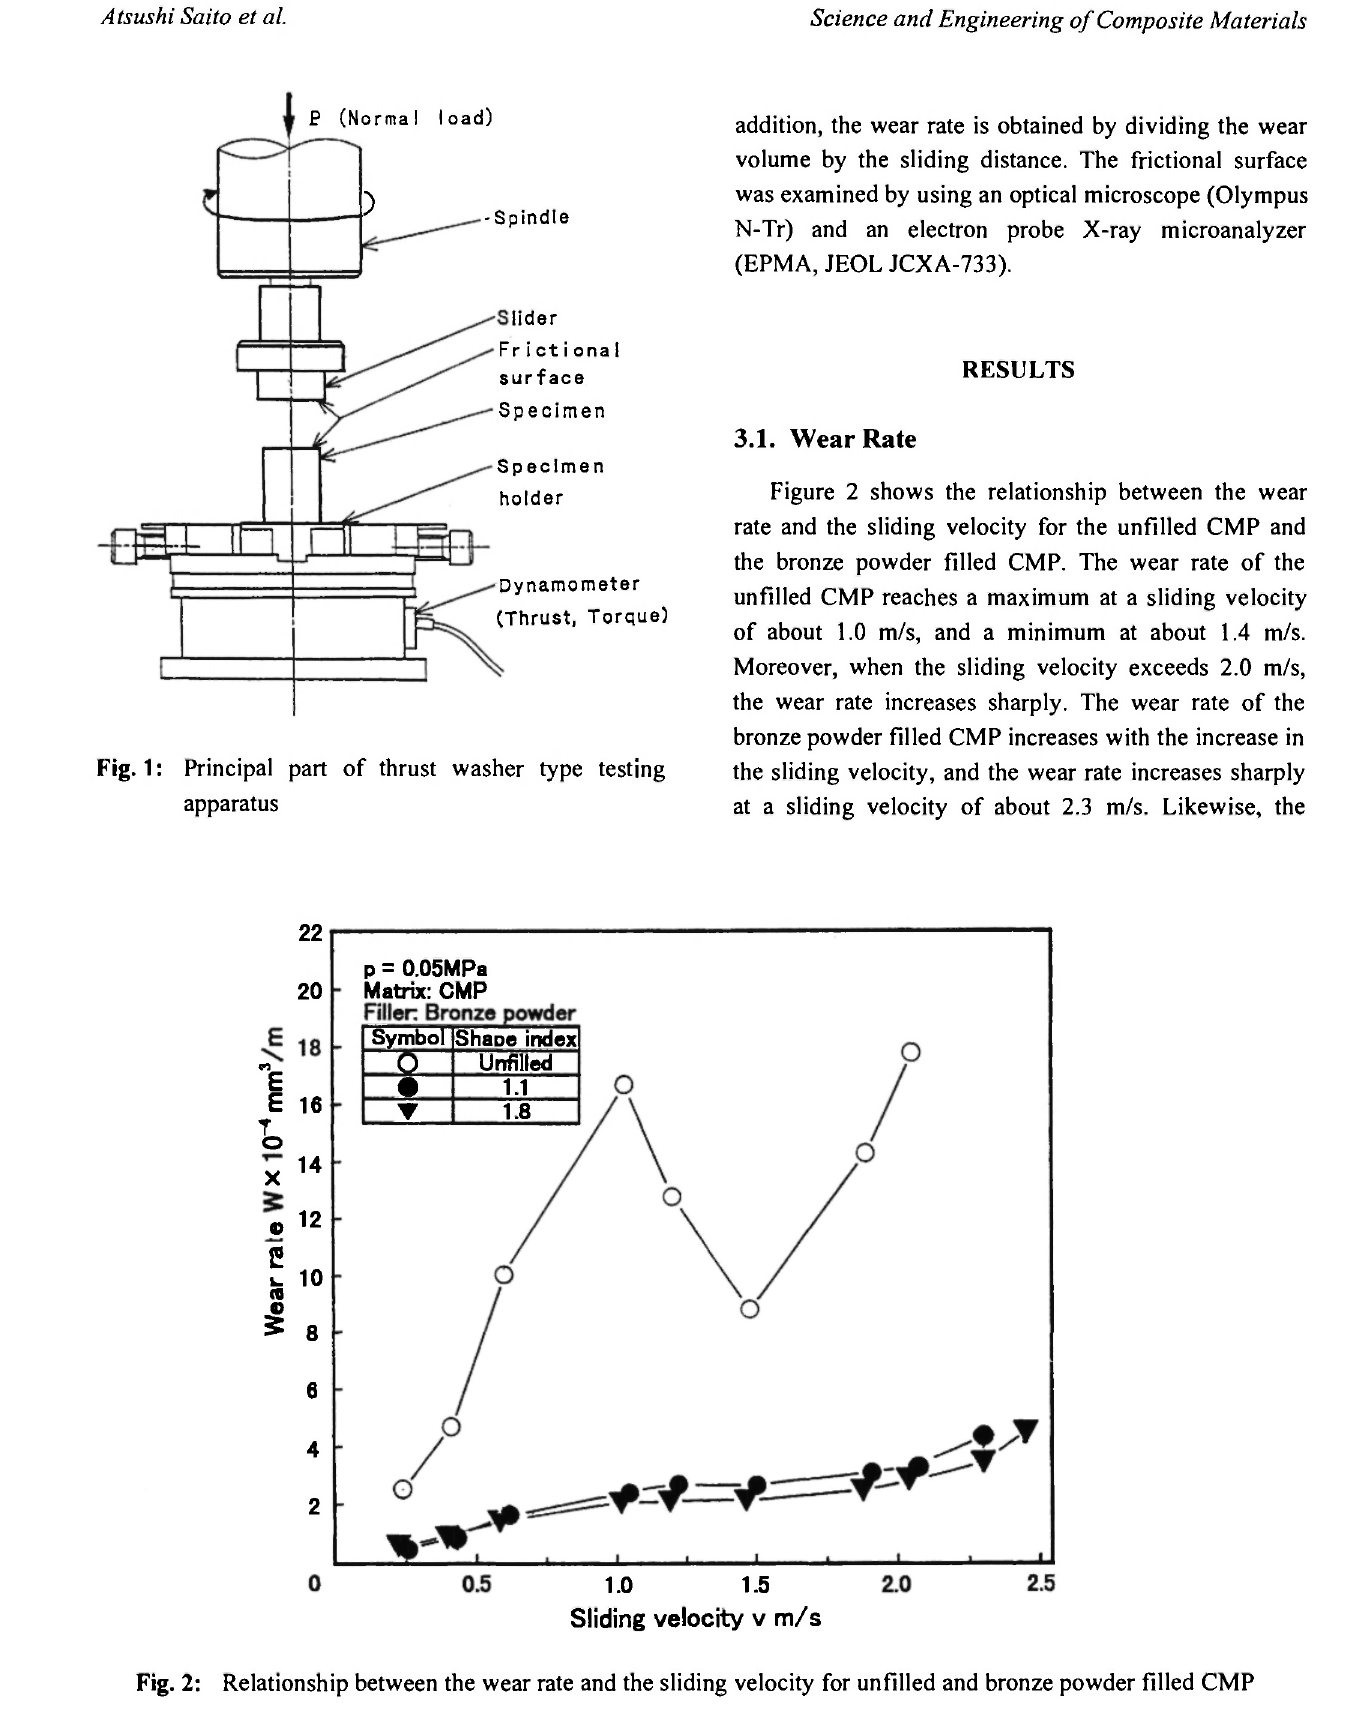
Fig. 2: Relationship between the wear rate and the sliding velocity for unfilled and bronze powder filled